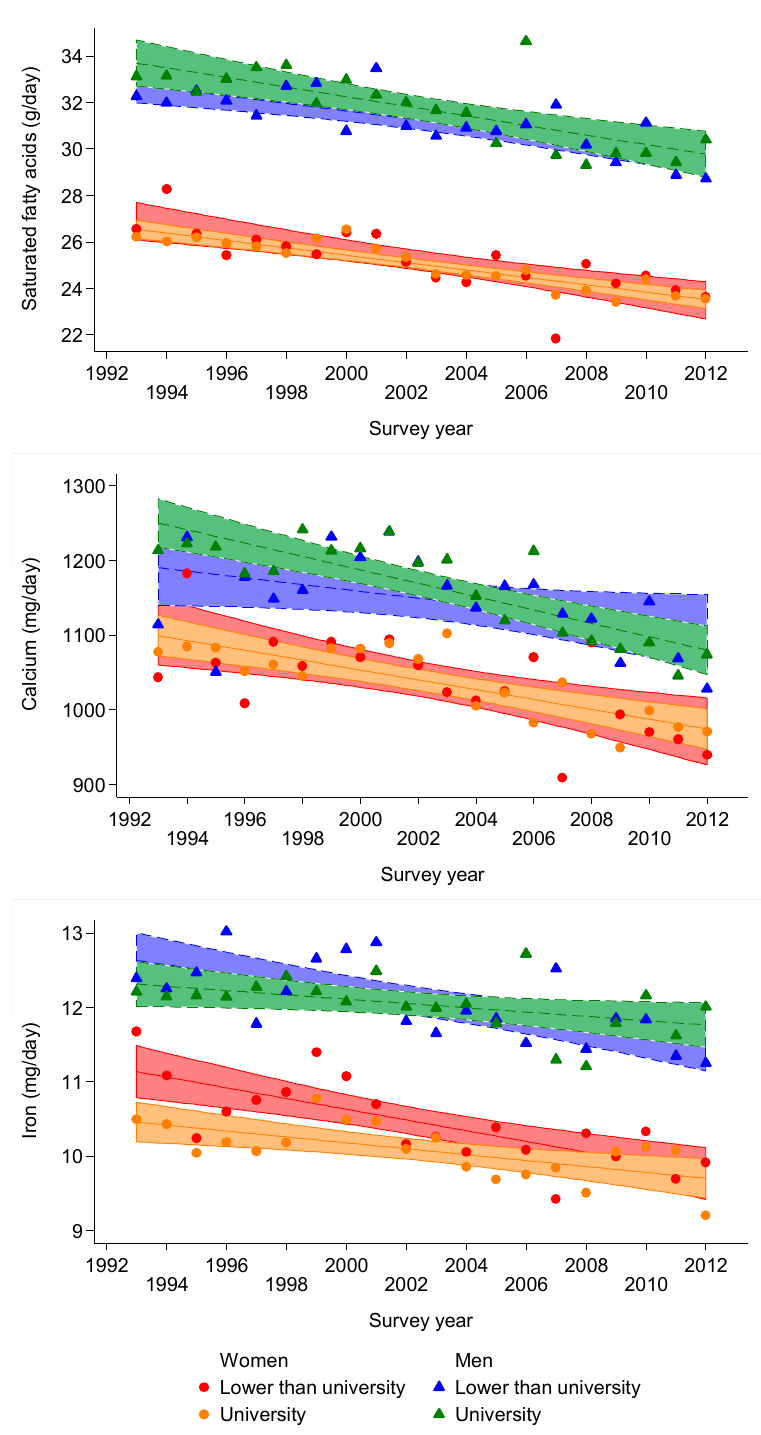
Figure 1. Unadjusted trends for saturated fatty acids ( upper panel ), calcium ( middle panel ) and iron ( lower panel ) according to gender and educational level, 1993–2012, Geneva, Switzerland.